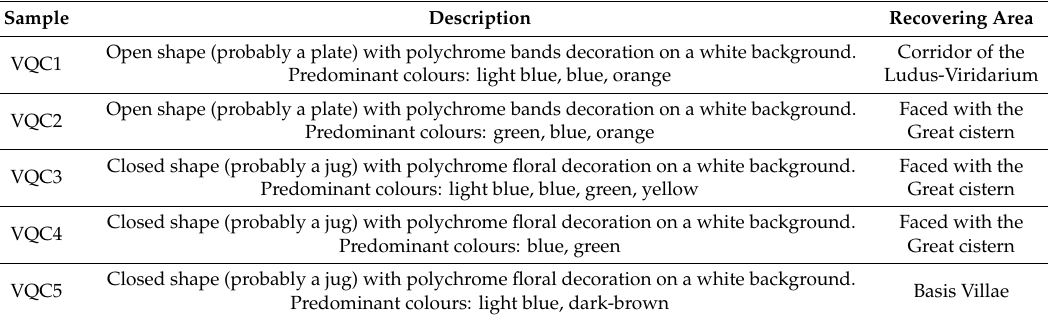
Table 1. Macroscopic features of investigated samples together with the recovering area according to Figure 2b.